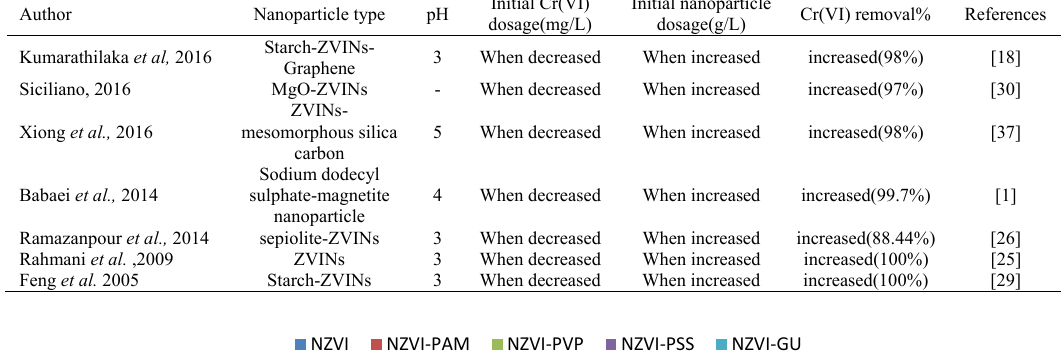
Table 4. The study results of some researches for Cr(VI) removal from aqueous solutions.